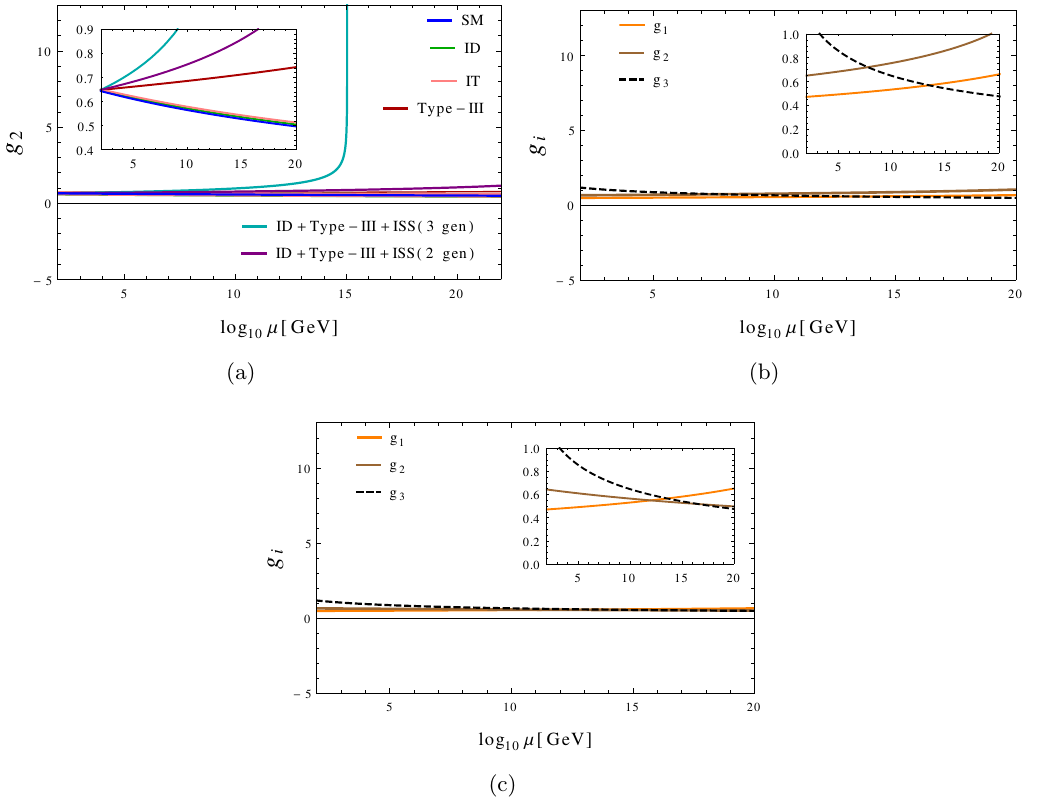
Figure 1 . (a) Running of g 2 with the scale (cid:22) for the SM in blue, SM + ID in green, SM + ITM in pink, SM + three generations of Type-III fermions in red, SM+ID + three generations of Type-III fermions in sky-blue and SM+ ID+ two generations of Type-III fermions in purple in two-loop. (b) Running of all three gauge couplings g i at two-loop for the SM+ ID+ two generations of Type-III fermions. (c) Running of all three gauge couplings g i at two-loop for the